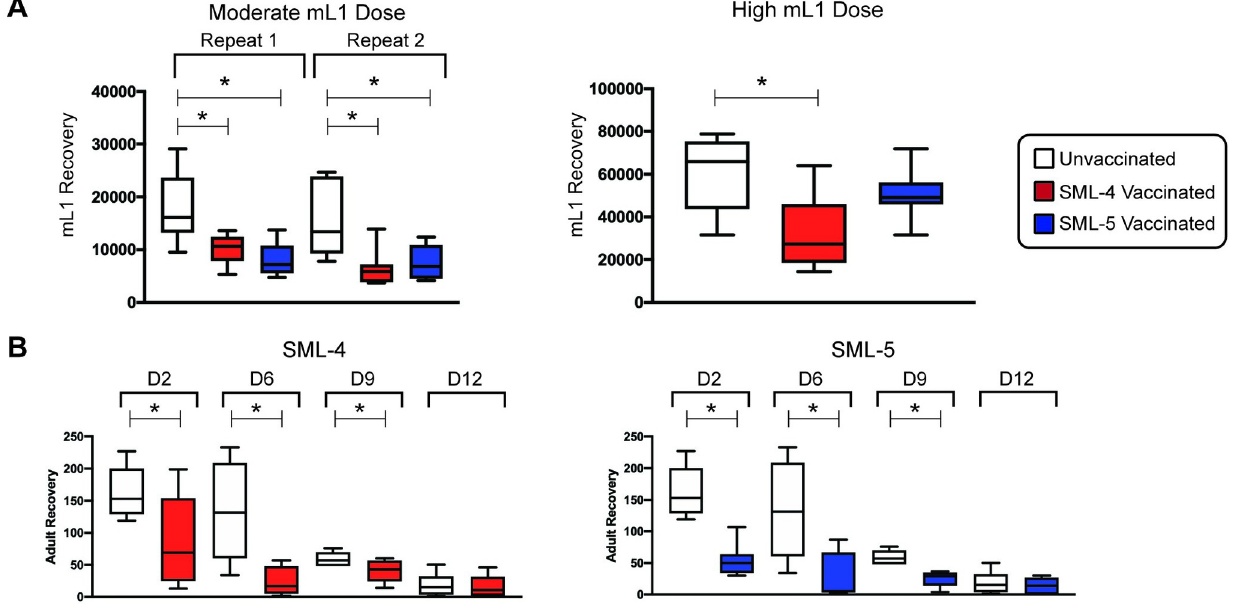
Fig 7. Vaccination with SML-4 and SML-5 is protective against T . spiralis infection. (A) BALB/c mice vaccinated with SML-4 or SML-5 protein, or unvaccinated control mice, were challenged with a moderate (250) or high (500) dose of infective mL1, and at forty days post-infection, the number of encysted mL1 collected from vaccinated mice was determined. (B) The number of adult worms recovered from vaccinated mice challenged with a moderate dose of infective mL1 was quantified at 2, 6, 9, and 12 days post-infection. Each experimental group contained 6–8 mice per time point for both A and